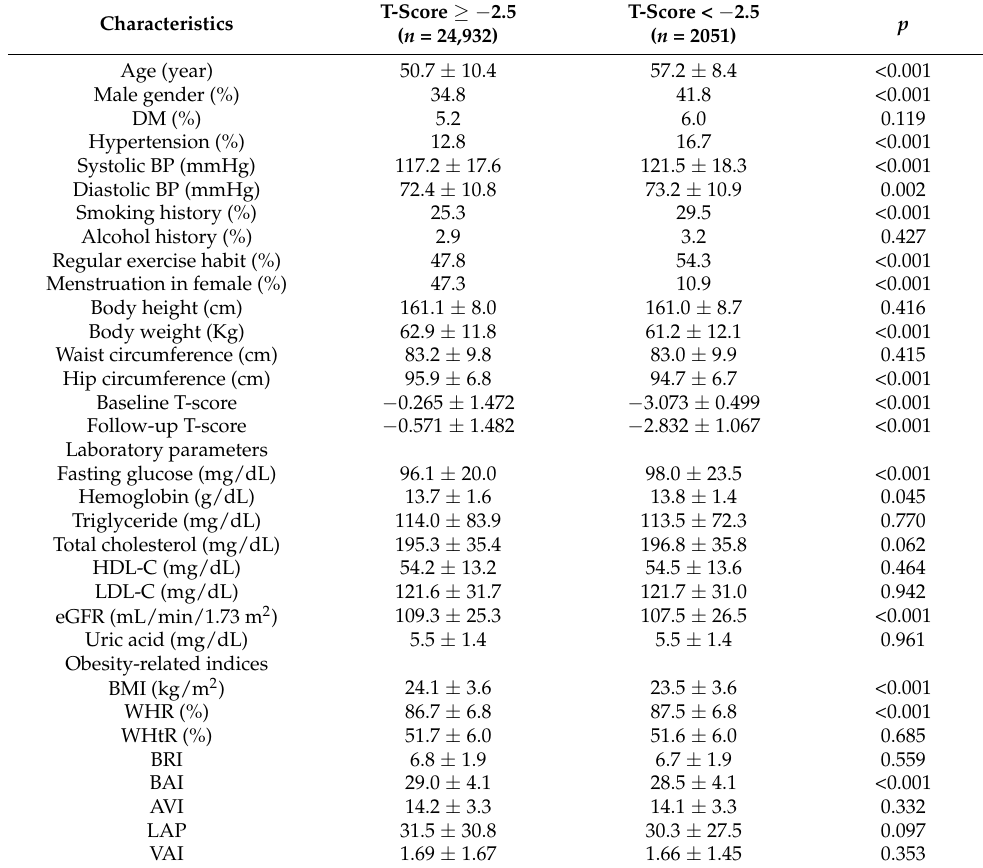
Table 2. Comparison of clinical characteristics among participants according to T score ≥ − 2.5 or < − 2.5.